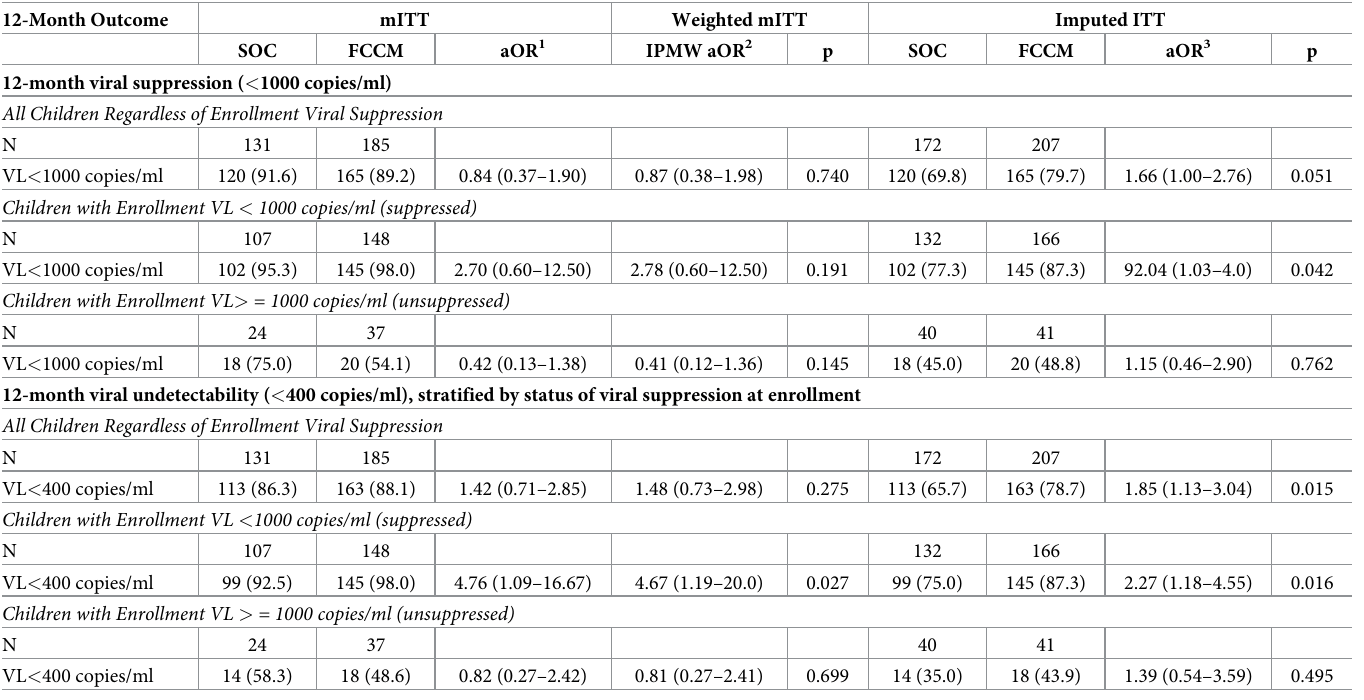
Odds Ratio adjusted for differences in study group characteristics at enrollment. 2 Odds Ratio adjusted for differences in study group characteristics at enrollment and weighting for outcome missingness. 3 Odds Ratio adjusted for differences in study group characteristics at enrollment with imputed